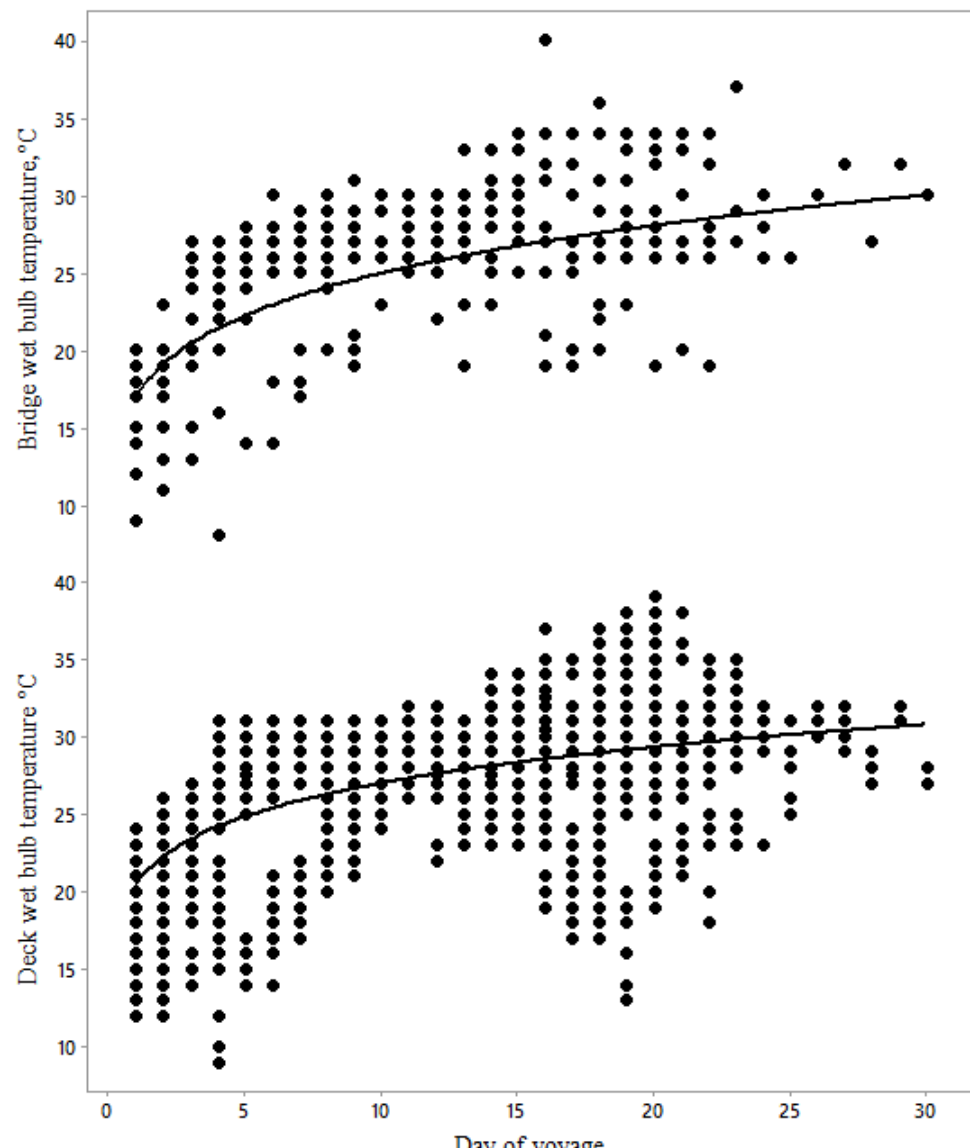
Figure 1. Changes in bridge T WB (°C) and deck T WB during days of all 14 voyages, described by the following equations: Bridge T WB , °C = 17.05 (±0.16) × Day 0.17(+0.004) , F = 17.79 and p < 0.0001 (Equation 1); Deck T WB , °C = 20.55(±0.19) × Day 0.12(+0.004) , F = 13.34 and p < 0.0001 (Equation 2), ( n = 3533).